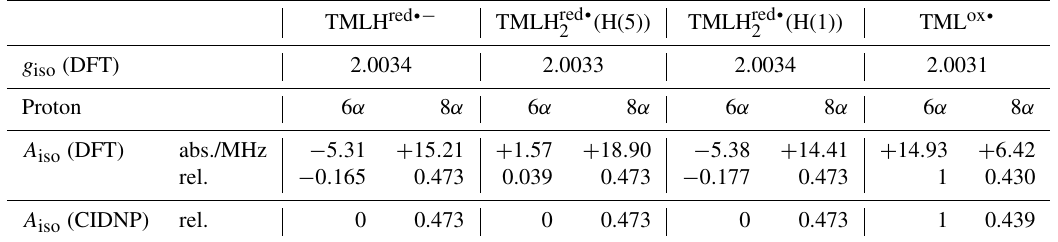
Table 1. Isotropic g values and selected isotropic methyl proton hyperfine couplings for various oxidized and reduced 6,7,8- trimethyllumazine